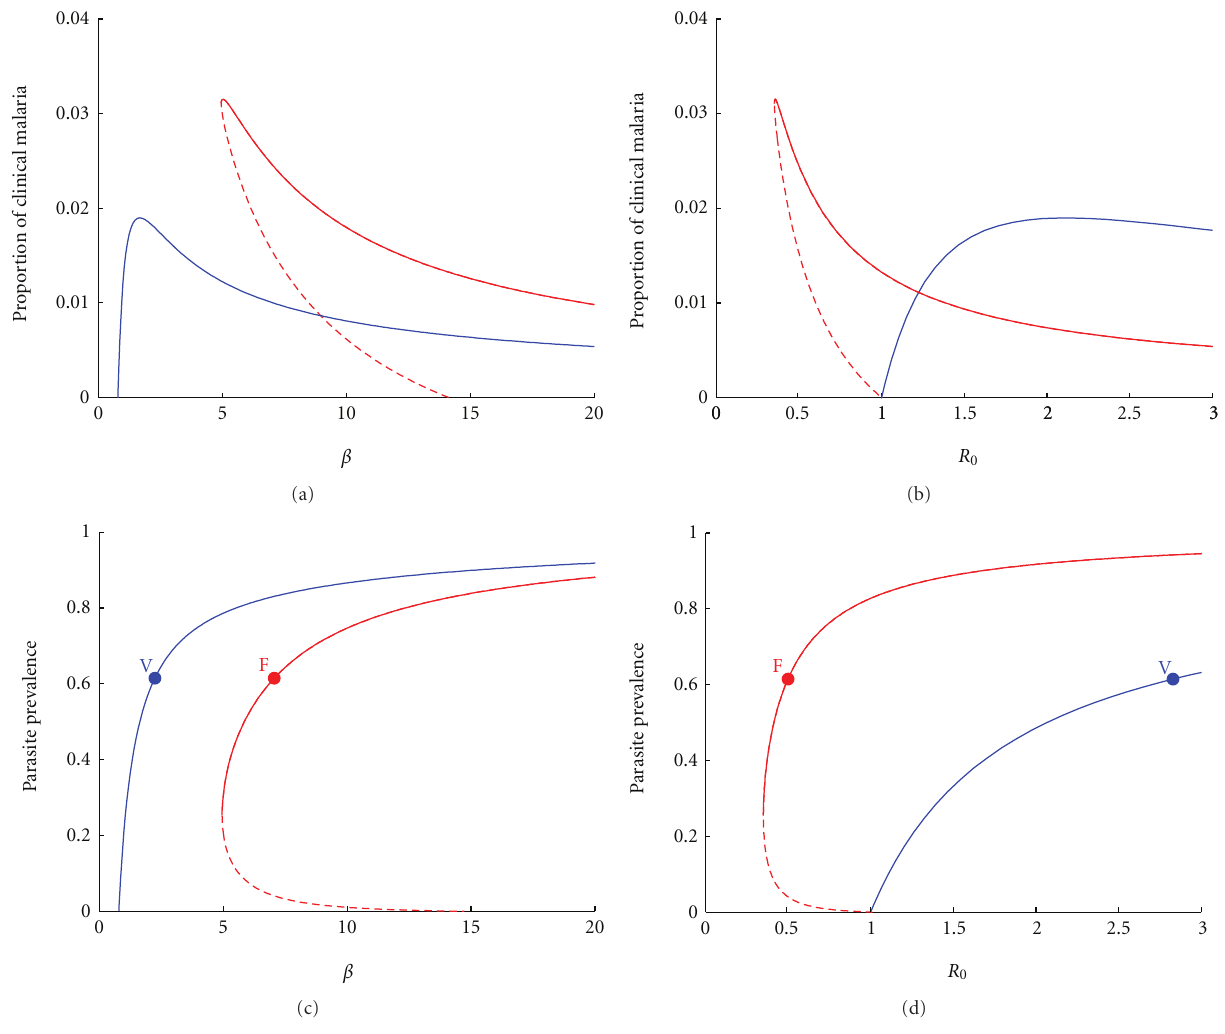
Figure 2: Expected clinical malaria episodes and parasite prevalence at equilibrium, for both P. vivax and P. falciparum . (a) Bifurcation diagram, showing the influence of β on the equilibrium levels of clinical malaria for P. vivax (blue) and P. falciparum (red). (c) Influence of I β on the equilibrium levels of parasite prevalence ( I 1 + 2 ) for P. vivax (blue) and P. falciparum (red). (b) and (d) are similar to (a) and (c), respectively, but use R 0 as control parameter. For P. vivax , we used p 1 = p 2 = 0 . 25. Dashed lines represent unstable equilibrium solutions, whilst full lines refer to stable endemic